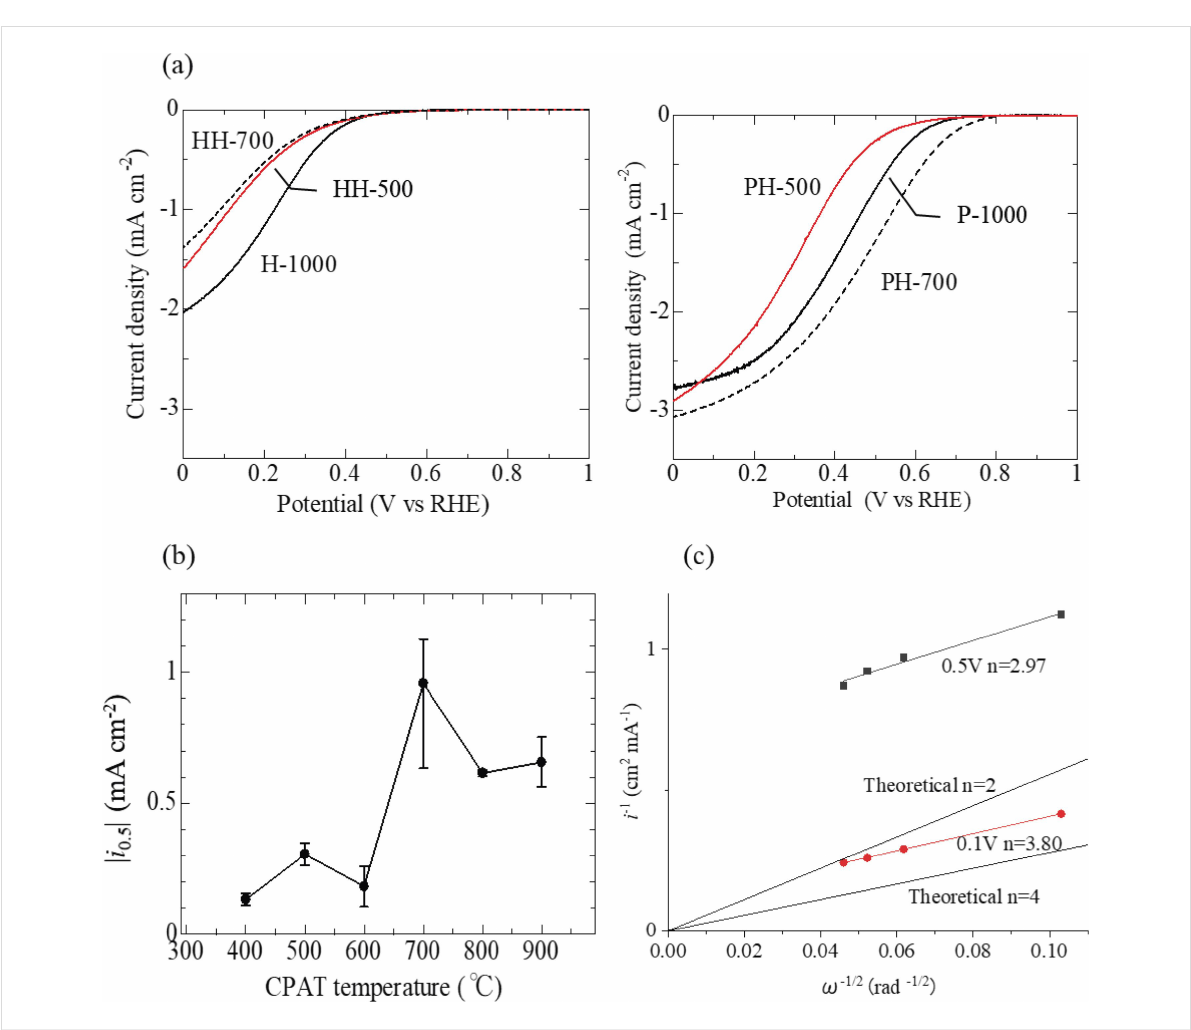
Figure 7: Results of ORR activity studies. (a) ORR voltammograms of HH- and PH-series carbon materials recorded in 0.5 M O 2 -saturated aqueous H 2 SO 4 . (b) Dependence of the ORR activity (represented | i 0.5 |) on the CPAT temperature. (c) Koutecky–Levich plots obtained for PH-700 using data acquired at 0.1 V and 0.5 V vs RHE.